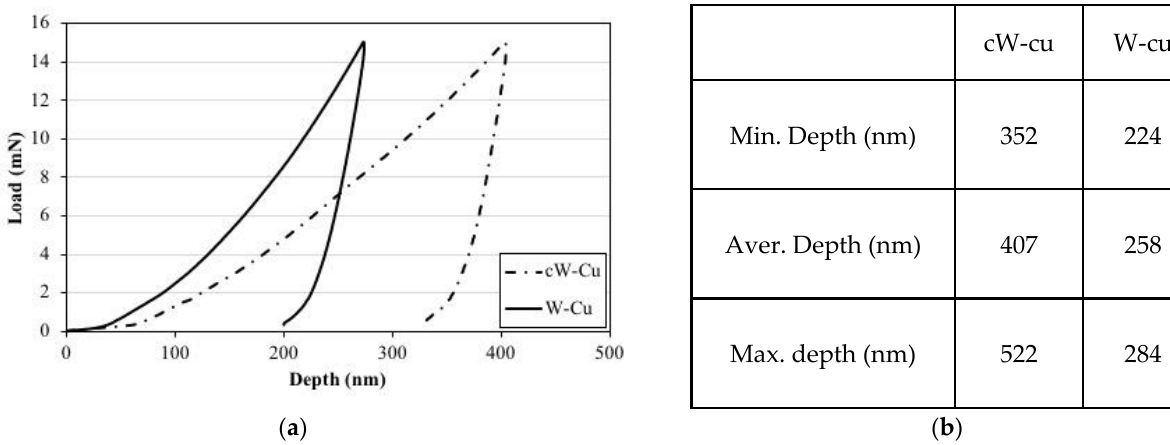
Figure 8. ( a ) The experimental results of cW-Cu and WCu specimens in accordance with ISO 14577, and ( b ) the scatter of the nanoindentation results.